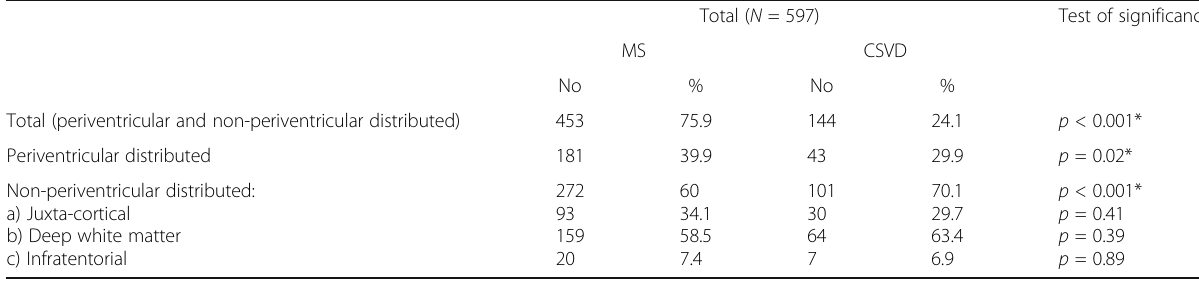
Table 2 Lesion distribution presented as number and percentage